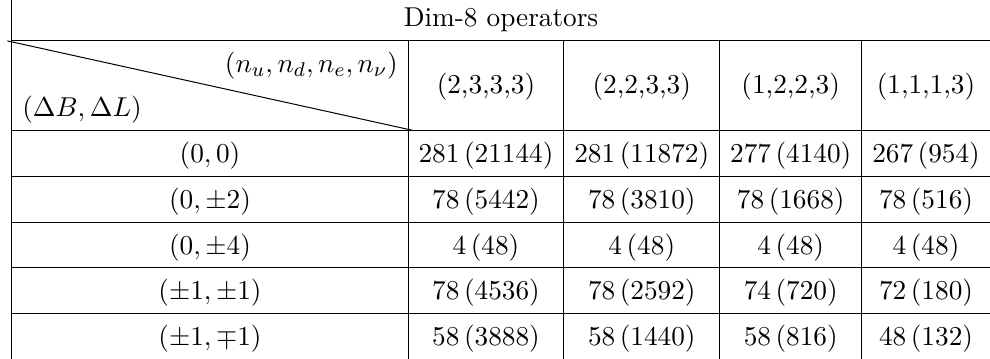
, n , n and n represent active number u d e ν = 2 and u = 3 , 2 , 1 corresponds active e